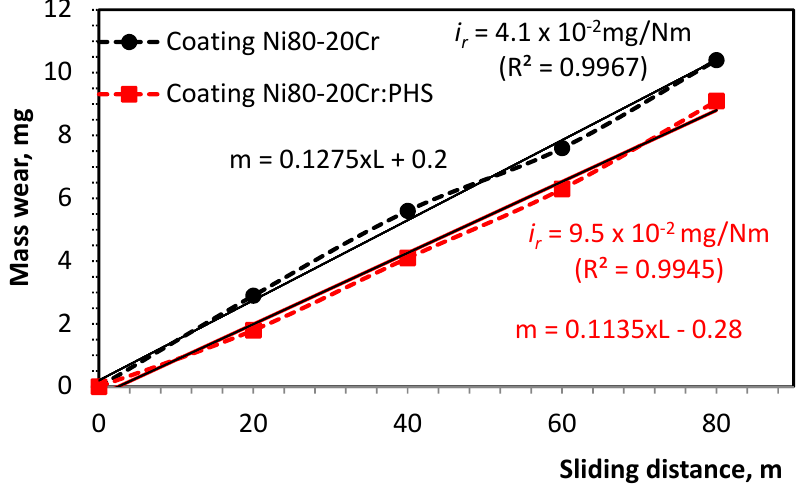
Figure 7. Mass wear vs. sliding distance for Ni80-20Cr and Ni80-20Cr: PHS coatings.